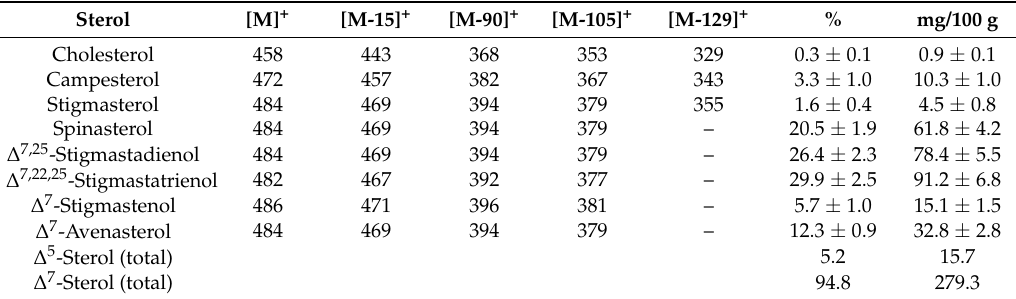
Table 3. Fragmentation ions used for identification of trimethylsilyl ether (TMSE) sterols of pumpkin ( C. maxima , var. Berrettina) seed oil and sterol composition (% and mg/100 g oil; mean value ± SD, n = 3). Sterol